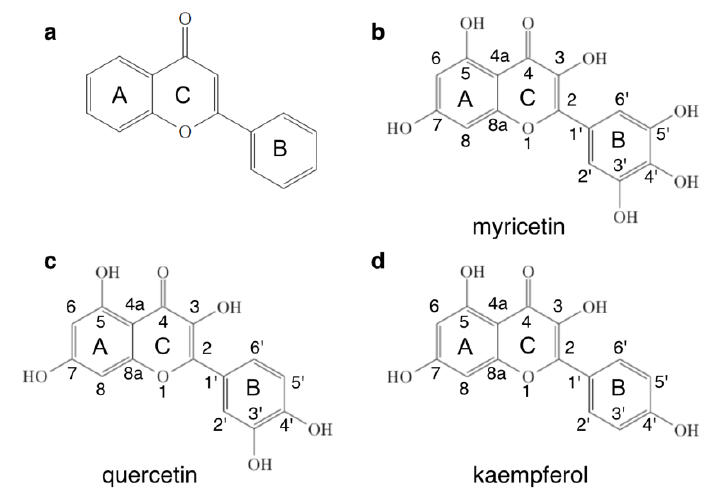
Figure 1. ( a ) Basic chemical structure of flavonol (2-phenyl-4H-1-benzopyran-4-one). Molecular structure of ( b ) myricetin, ( c ) quercetin, and ( d ) kaempferol. The A, B, and C rings and the numbering are shown.